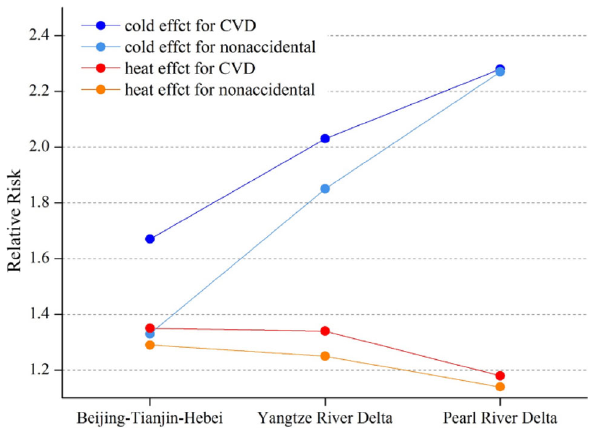
Fig. 5 Cold/heat effects in the three city clusters of eastern China